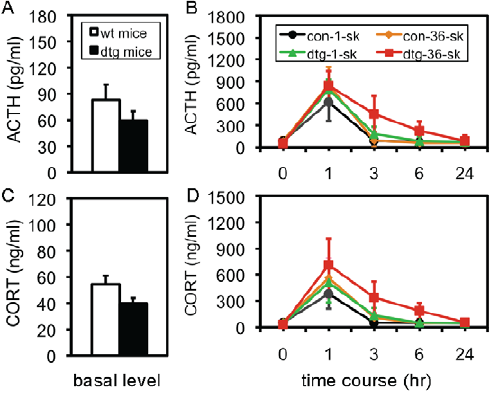
Figure 6. Increased HPA axis activity in tg mice following 36 trials of footshock. (A) Basal serum level of ACTH in naı¨ve control mice (con-naı¨ve) and naı¨ve tg mice (tg-naı¨ve). A tendency of a lower level is shown, but it is not significant. Data are expressed as mean